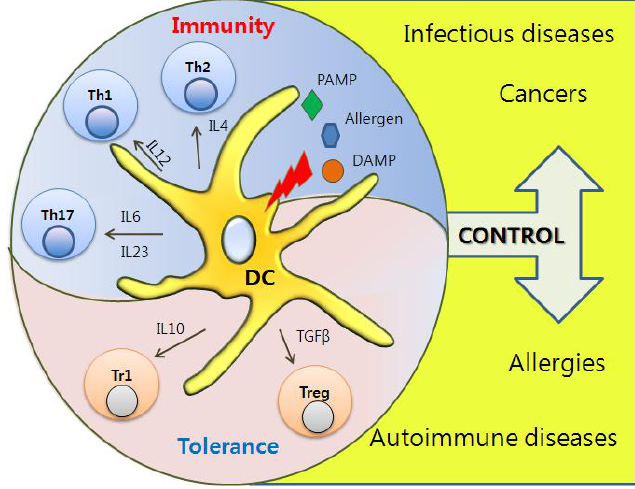
Figure 3. Immunological Roles of DCs. PRR-induced DCs can instruct distinct T helper cell differentiation depending on cytokines, which play a key role in